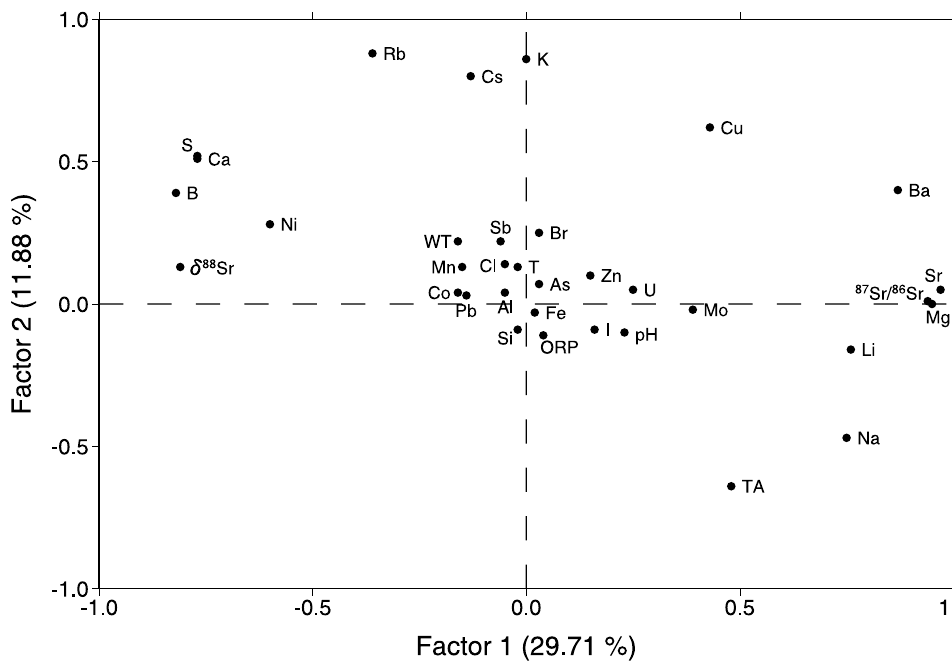
Fig. 4 Factor loading plot for F1 versus F2